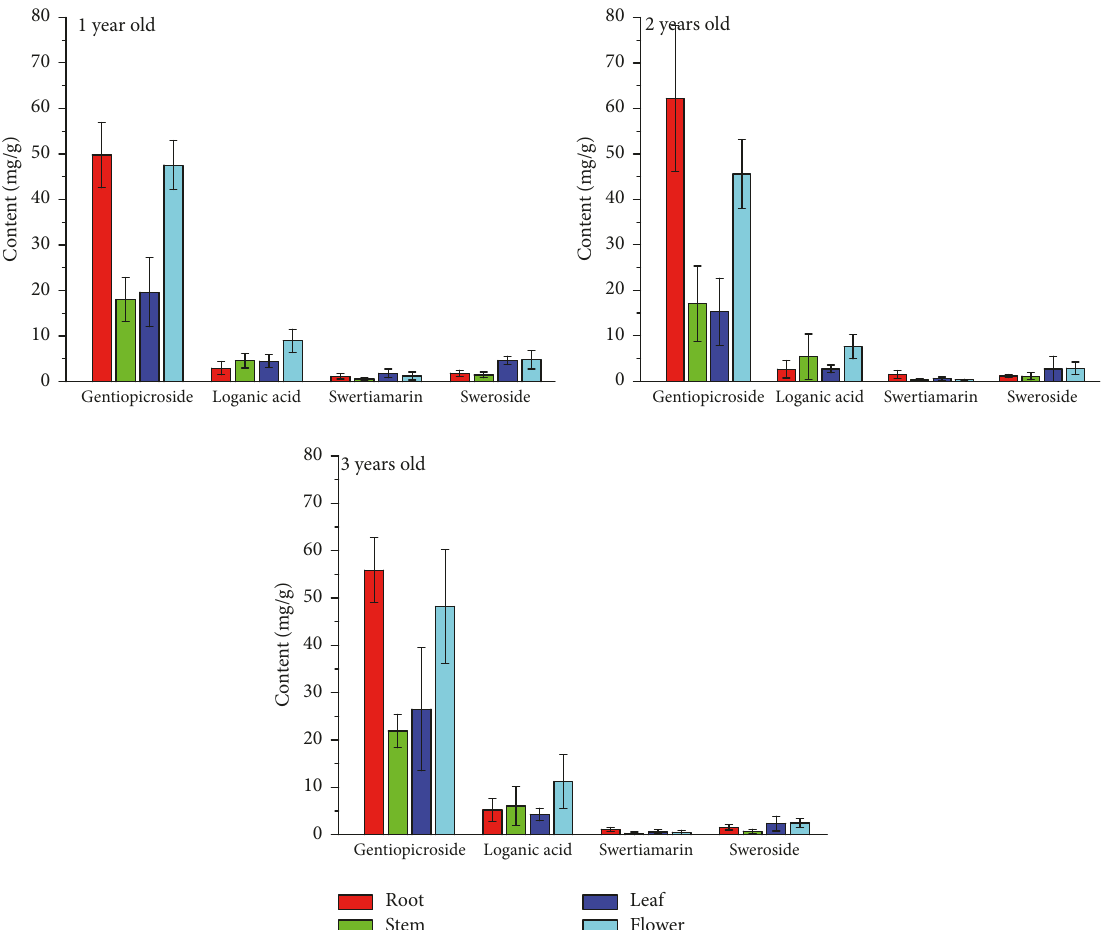
Figure 2: Quantitative variation of iridoid glycosides between different organs. (Description: this figure shows the quantitative variation of four iridoid glycosides between different organs of 1-, 2-, and 3-year-old G. rigescens resources based on HPLC method. The content of metabolites is represented as the average value and the standard deviations of these metabolites are also